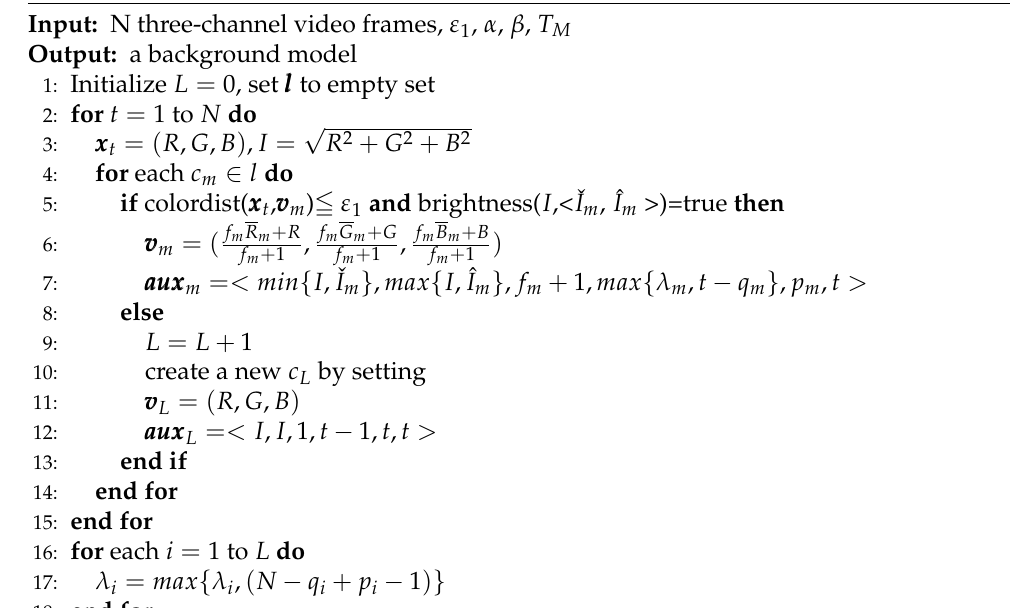
Algorithm 1 Codebook background modeling